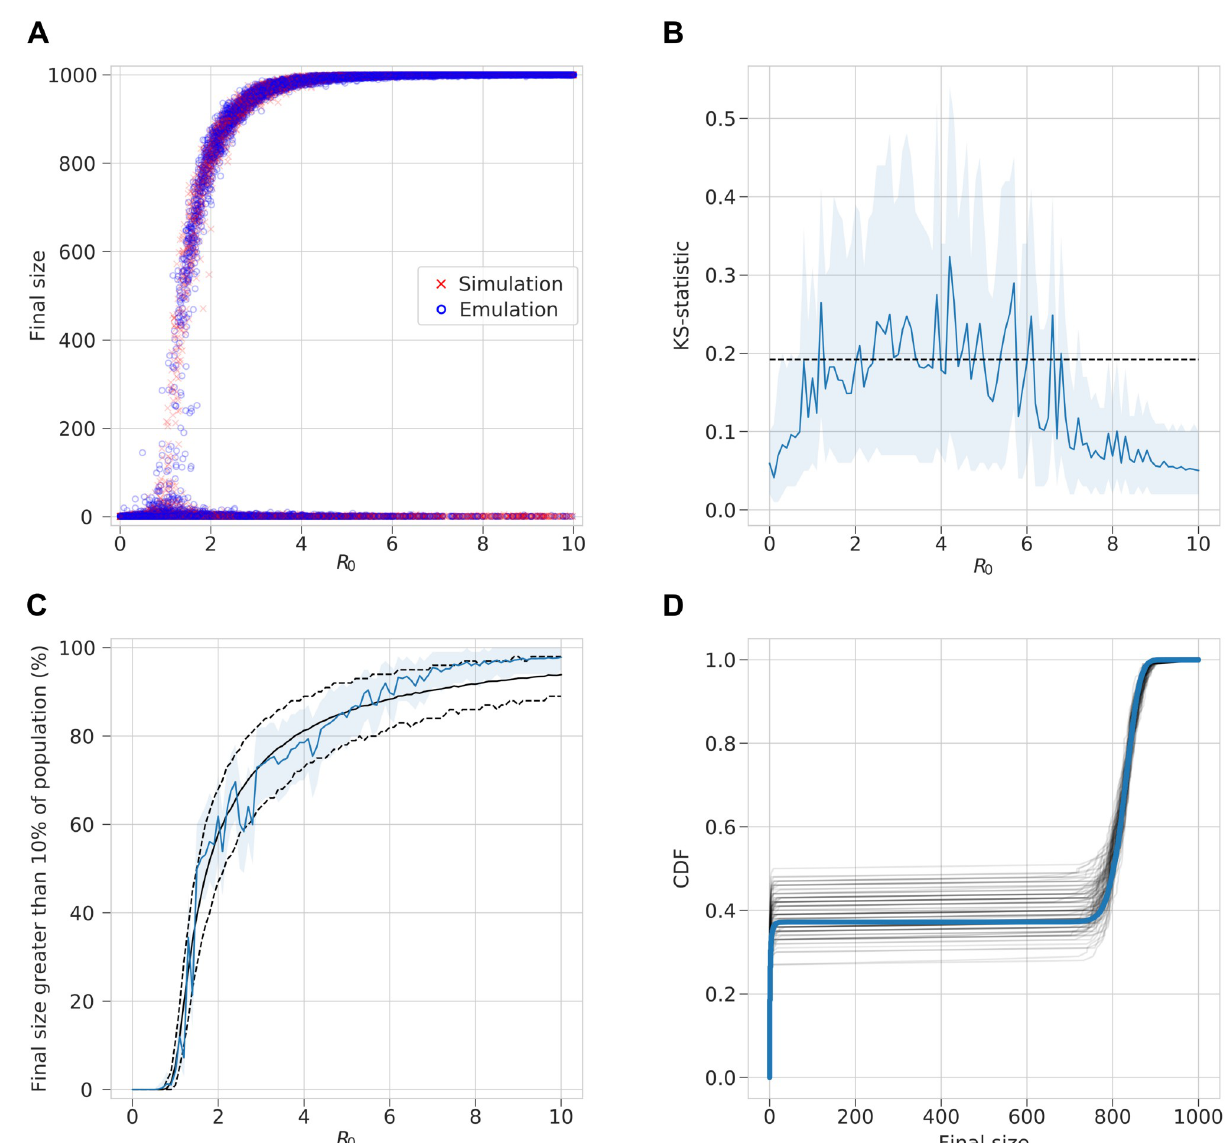
Fig 3. Binomial-MDN output emulating the final size distribution of a stochastic SIR model. (A) For random uniform sampling over β and γ a sample of the output from MDN across values for the basic reproductive number R 0 = β / γ are shown in blue and the directly simulated values are shown in red. (B) Corresponding two-sample K–S statistic where sample of 100 points are drawn from a negative binomial and the MDN over a range of R 0 values. 100 replicates are used to estimate a mean K–S statistic and a 95% range. Dashed line represent significance at α = 0.05, with values less indicating the two samples do not differ significantly. (C) The percentage of 1,000 realisations of the stochastic SIR model with final size greater than 100 is shown in black with dashed line showing a 95% range. Emulated results are shown by the blue line with a 95% range. (D) Example empirical CDFs drawn from 100 samples of MDN with inputs β = 0.4 and γ = 0.2. 1,000 empirical CDF are shown as black transparent lines and true CDF is shown as a blue solid